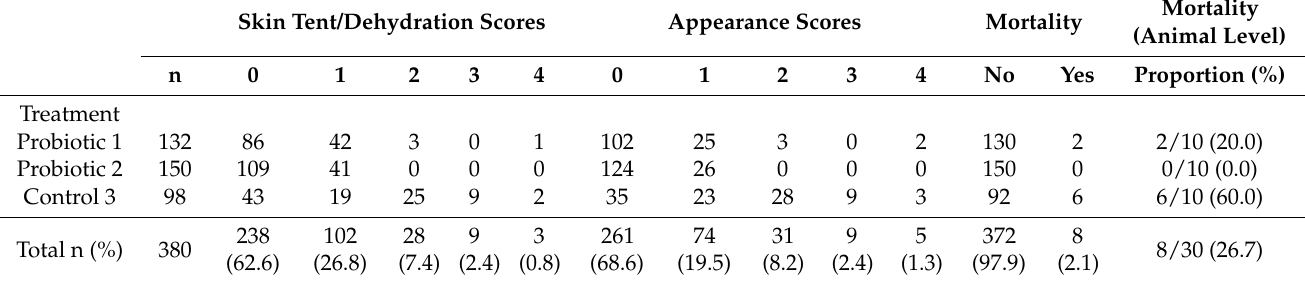
Table 6. Dehydration and appearance scores and animal level mortality by treatment group and study day in dairy calves supplemented with two probiotic products to reduce Clostridium perfringens . Skin Tent/Dehydration